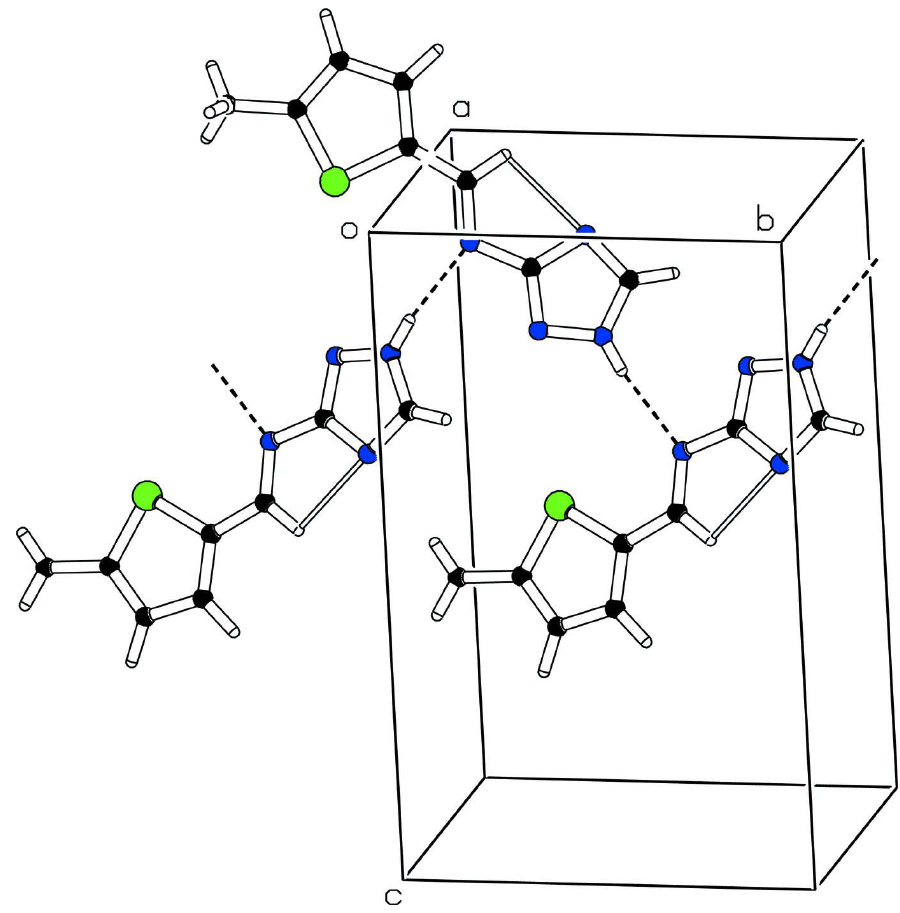
Figure 2 The partial unit cell packing of (I) (Spek, 2003) showing the interamolecular and intermolecular hydrogen bonding showing that polymeric sheets are